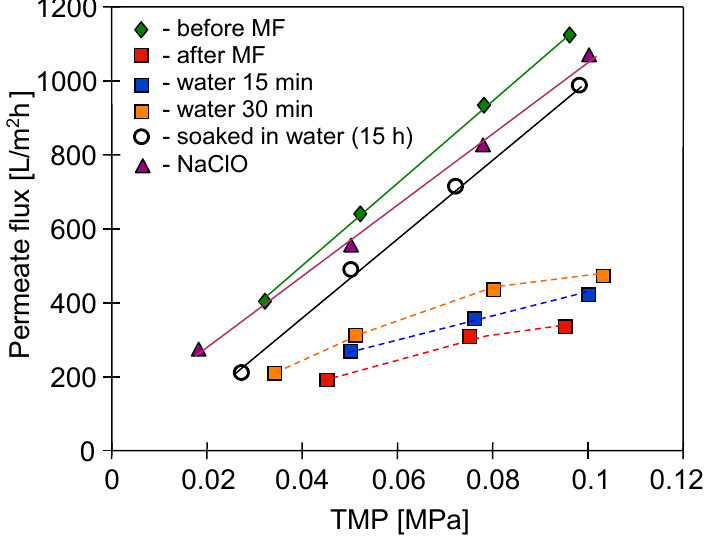
Figure 9. Variations in permeate flux during membrane cleaning after MF of model emulsion (C F = 150 mg/L, T = 25 °C).